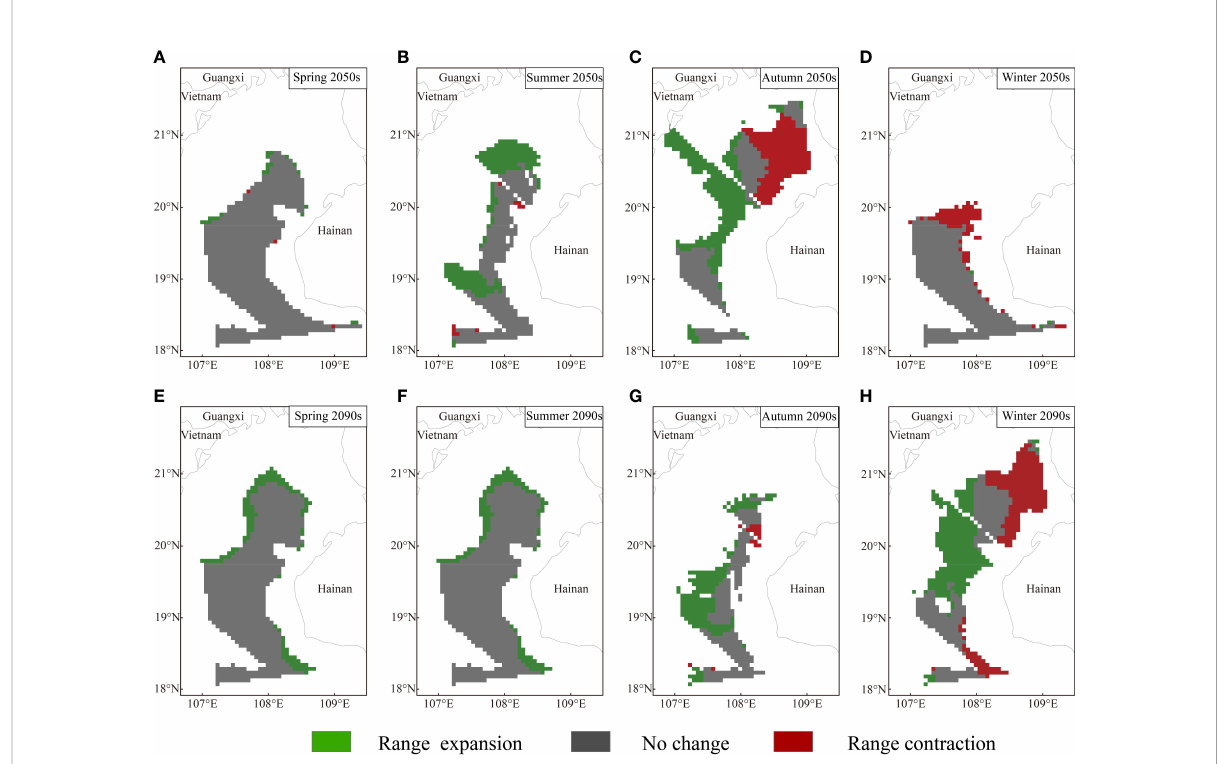
FIGURE 5 Projected range expansion or contraction of Trichiurus japonicus in the Beibu Gulf under RCP126. Area of geographic distribution changes among the species distribution models based on binary predictions for the current and future (i.e., in the 2050s and 2090s) climate conditions: (A) spring 2050s; (B) summer 2050s; (C) autumn 2050s; (D) winter 2050s; (E) spring 2090s; (F) summer 2090s; (G) autumn 2090s; (H) winter 2090s.